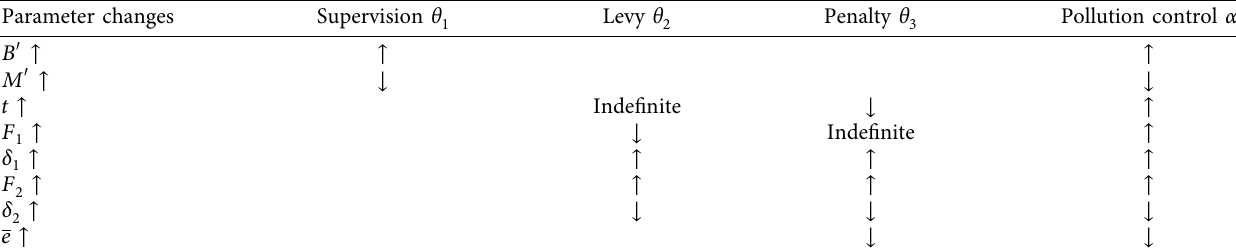
Table 2: The influence of parameter changes on game equilibrium.